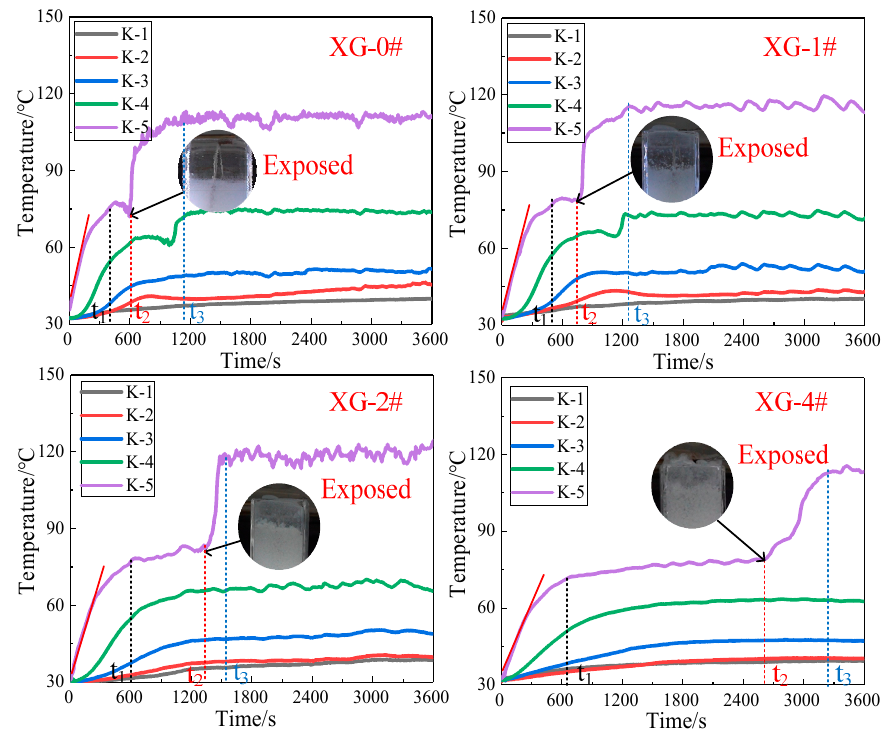
Figure 7. Temperature distribution inside foam layer at different positions under 200 °C. The time, t1, t2, and t3, and the temperature values (Tt1 and Tt3) reached at t1 and t3 are listed in Table 3. In addition, a linear fitting was performed on the K5 curves before t1, and the slope was recorded as K(0–t1), also listed in Table 3. All the values of t1, t2, and t3 increased gradually from XG-0# to XG-4#. The values of Tt1 and Tt3 were almost unchanged from XG-0# to XG-4#, but the time at which the temperature was kept at the relatively stable value of Tt1 increased obviously. The values of K(0–t1) decreased gradually.